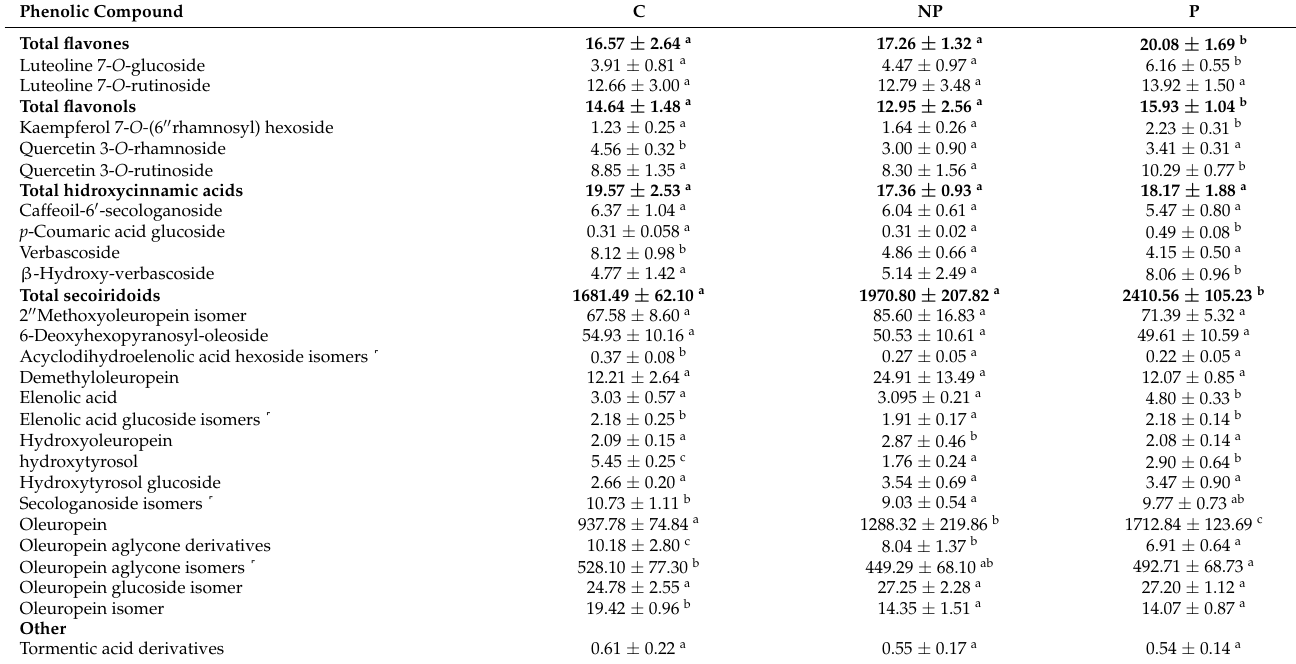
Table 3. Individual phenolic compounds (mg kg − 1 FW) of control fruits, pierced tissue of damaged fruits, and non-pierced tissue of damaged fruits in cultivar ‘Istrska belica’.